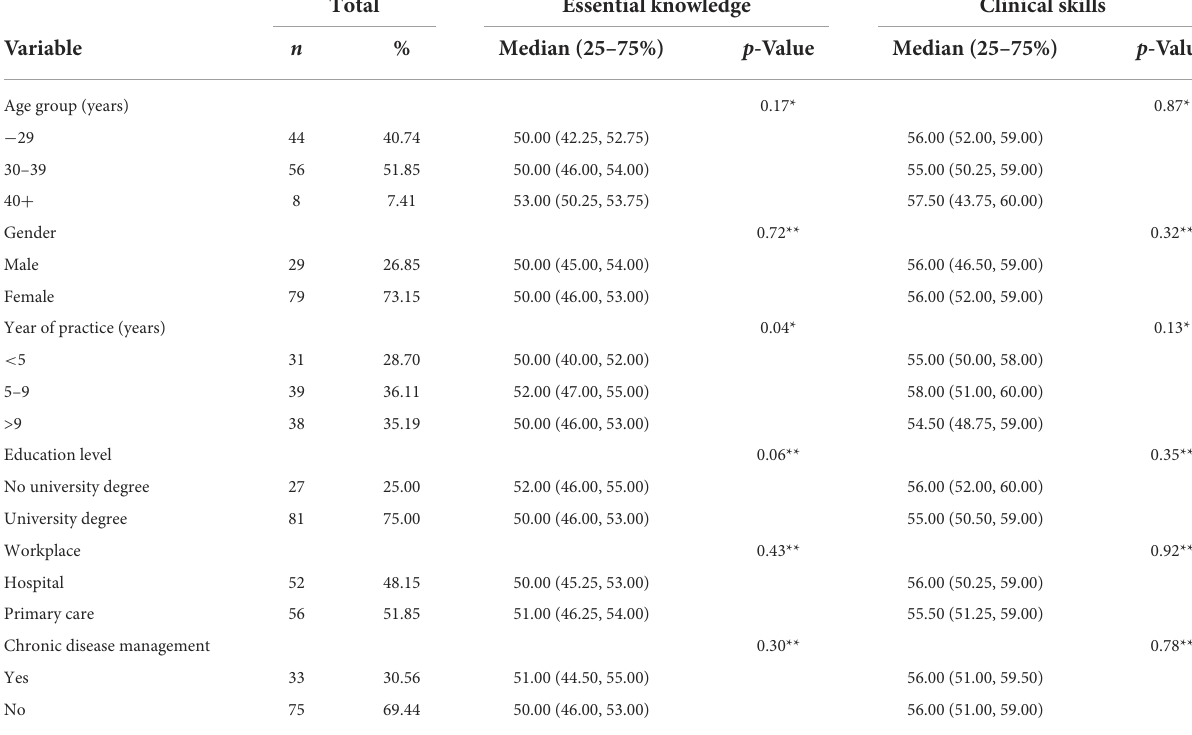
TABLE 1 Participants’ characteristics and training need